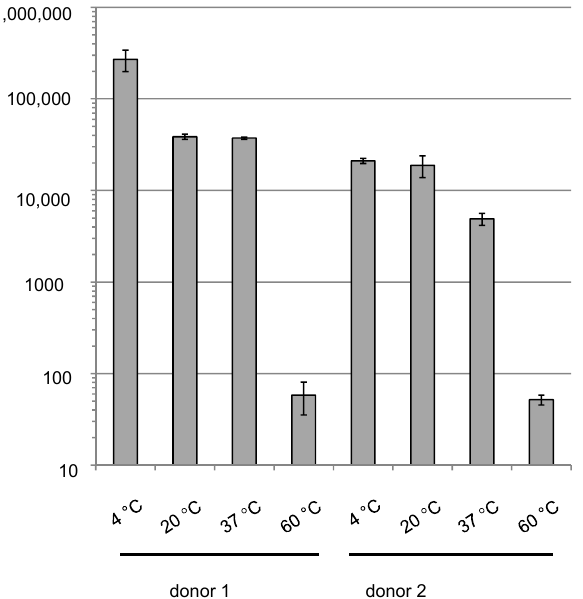
Figure 3. Influence of storage temperature on RNA signal strength during a 3-days period as a measure for shipping.